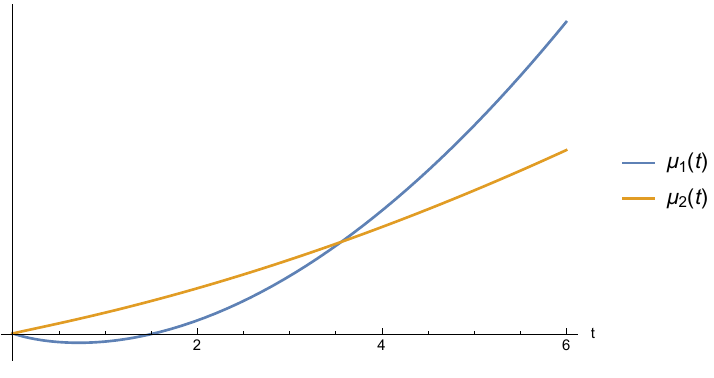
Fig. 14 The solutions of the initial value problem 40–41 for α = 0 .